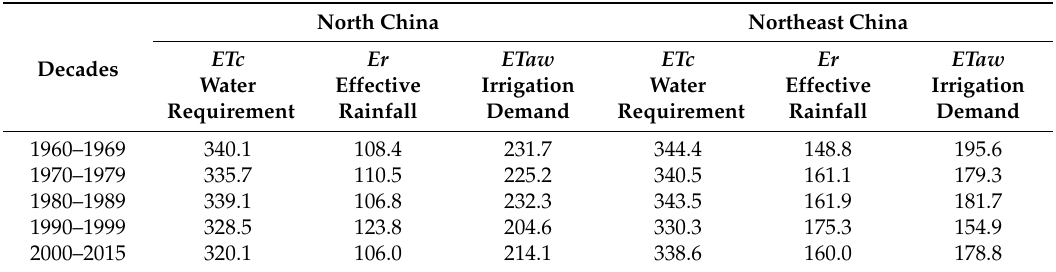
Table 1. Decadal variation in oat water requirements in North and Northeast China